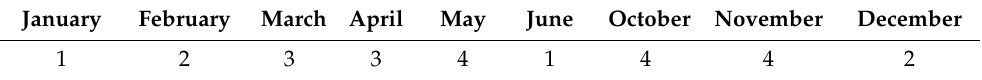
Table 2. Weather conditions w n coding values.